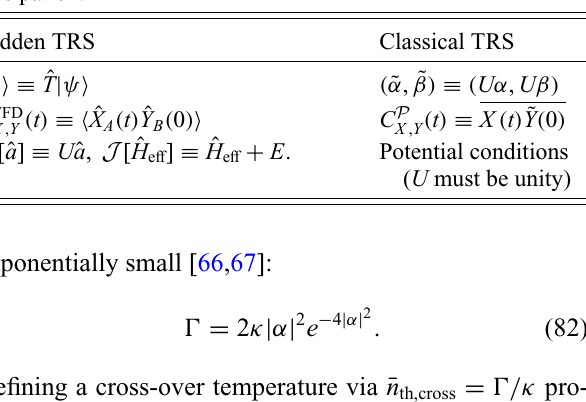
TABLE II. Dictionary connecting hidden TRS and an effec-